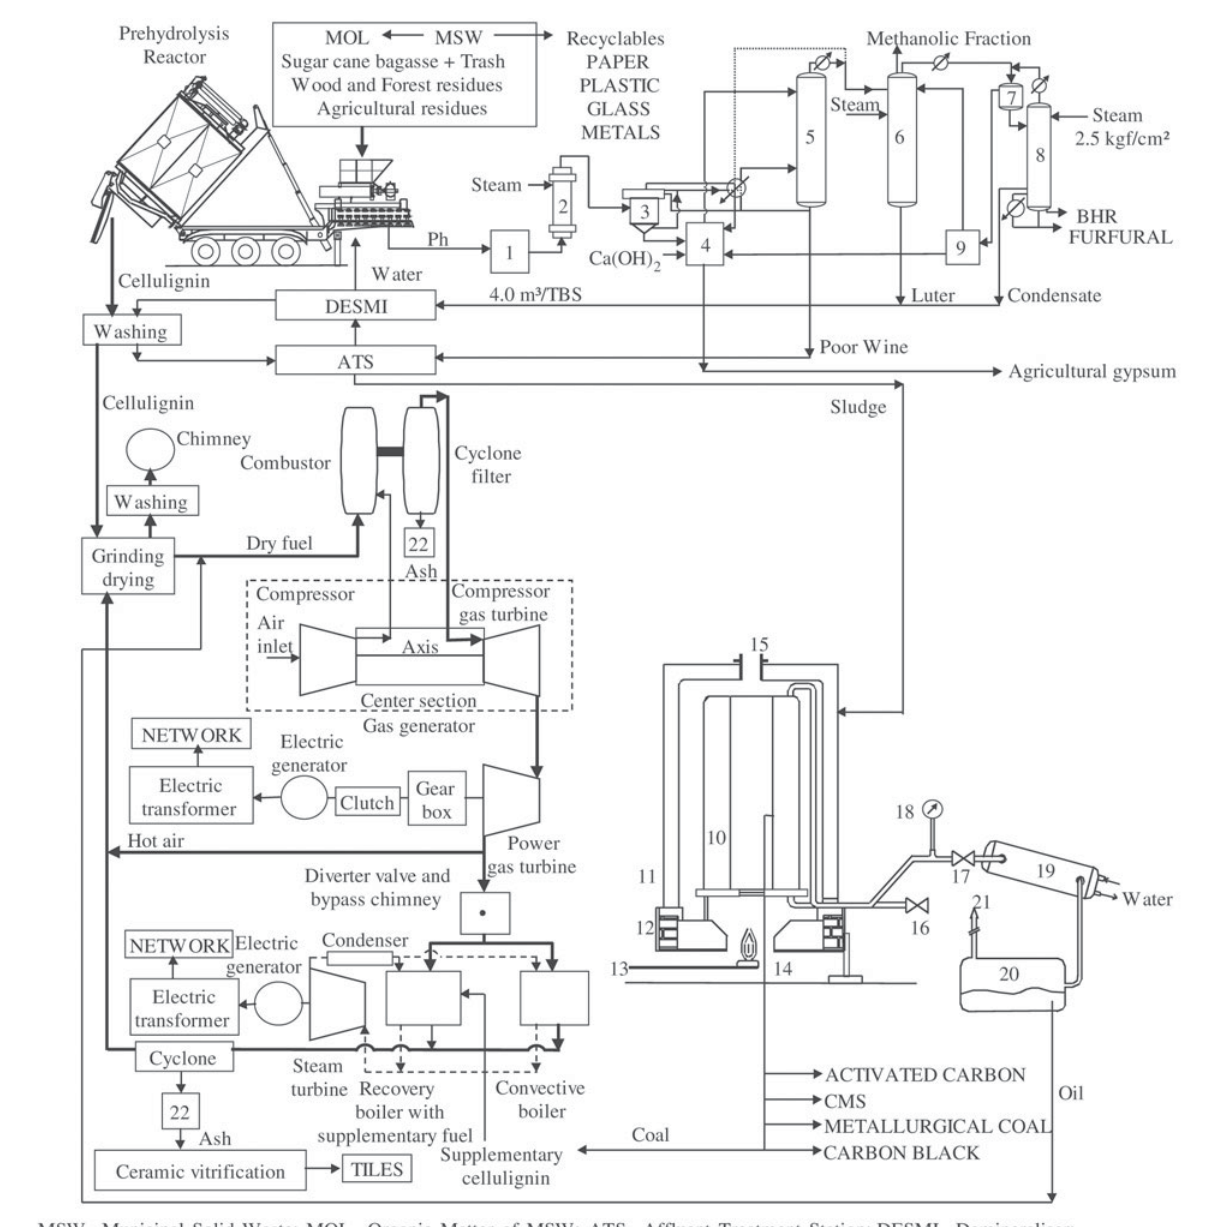
Figure 1. Biomass Refinery basic